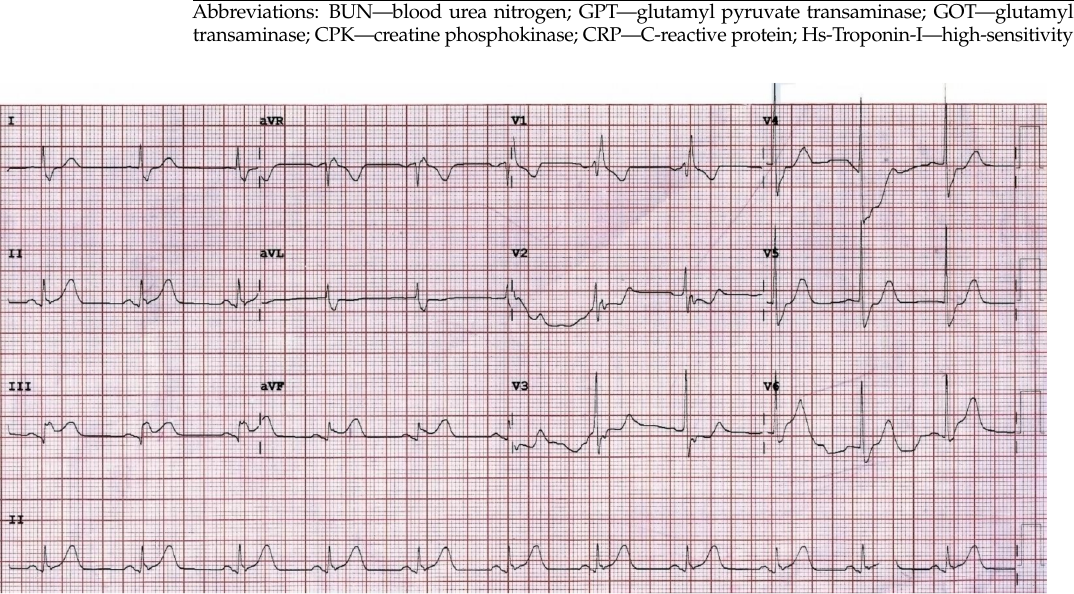
Figure 1. Twelve-lead electrocardiograms on admission. Right bundle branch block and elevation of the ST segment in leads III, and aVF.